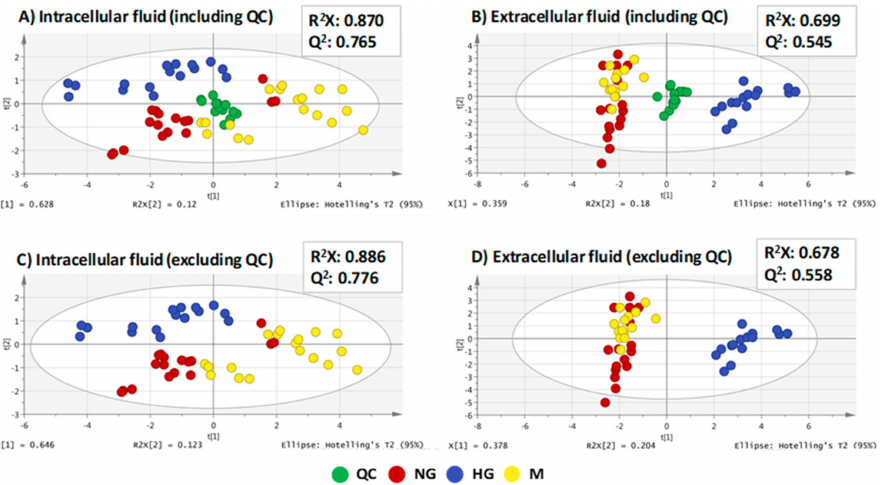
Figure 1. PCA including QC and excluding QC for the two analytical sequences: ( A ) intracellular fluid (including QC), ( B ) extracellular fluid (including QC), ( C ) intracellular fluid (excluding QC), and ( D ) extracellular fluid (excluding QC). QC, quality control. NG, normal glucose. HG, high glucose. M, osmotic